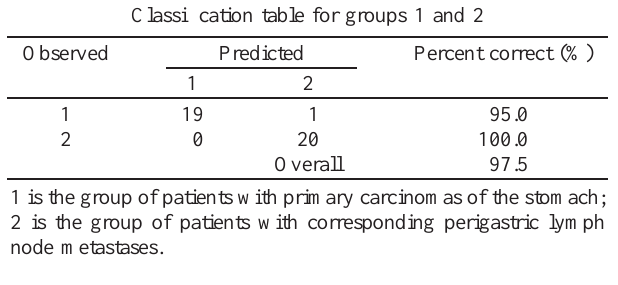
Table 2 Table for the predicted probabilities as well as the observed and predicted